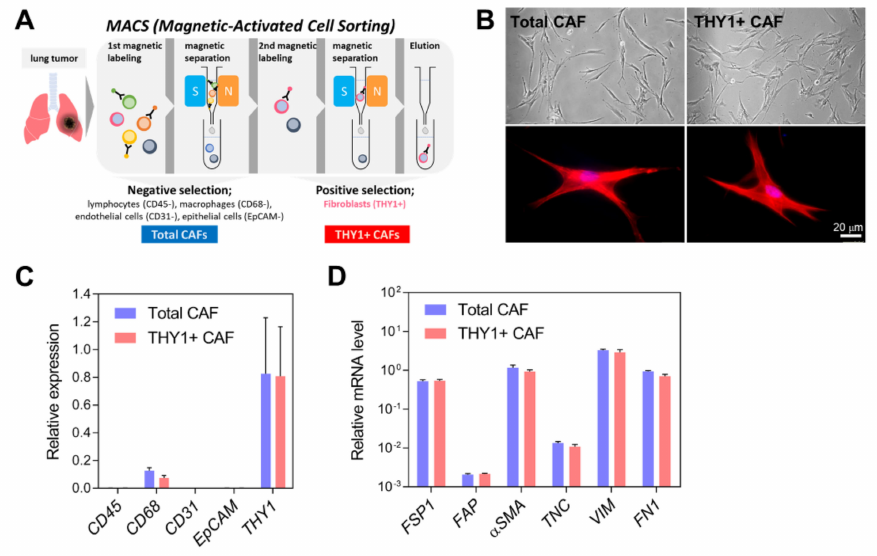
Figure 1. Isolation and characterization of CAFs. ( A ) Total CAFs and THY1 + CAFs were isolated from lung tumors via magnetic-activated cell sorting (MACS). Total CAFs were collected after negative selection using antibodies against CD45 (a lymphocyte marker), CD68 (a macrophage marker), CD31 (an endothelial cell marker), and Ep-CAM (an epithelial cell marker). THY1 + CAFs were then isolated using anti-THY1 antibodies. ( B ) Cell morphology of isolated CAFs. Representative phase-contrast (upper) and fluorescence microscopic images (bottom) are shown. Total and THY1 + CAFs were stained with phalloidin conjugated to Alexa 594 (red) and DAPI (blue). ( C ) qRT-PCR analysis of cell-type-specific markers in total and THY1 + CAFs. Expression levels were normalized to the RPL32 mRNA level. Data are presented as the mean + SD ( n = 3). ( D ) qRT-PCR analysis of CAF-specific markers in total and THY1 + CAFs. Data are presented as the mean + SD ( n =